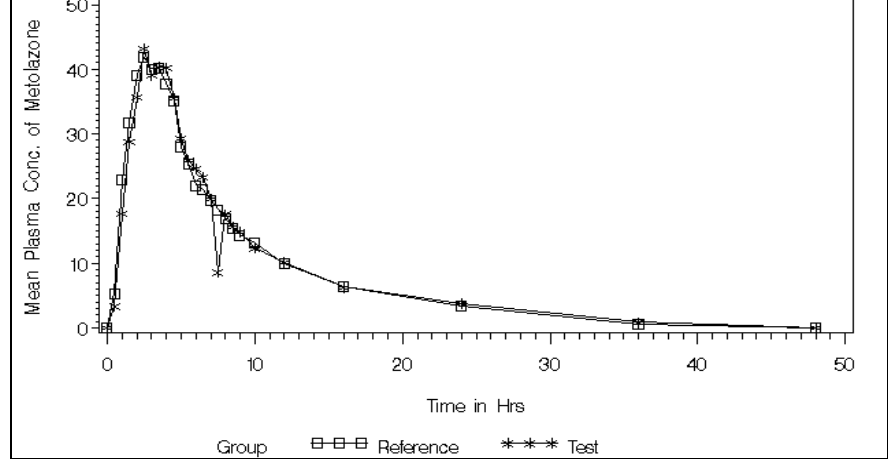
Figure 5. Mean plasma concentration –time profile of metolazone after a single oral dose of metolazone (USP 5mg) tablet to healthy male